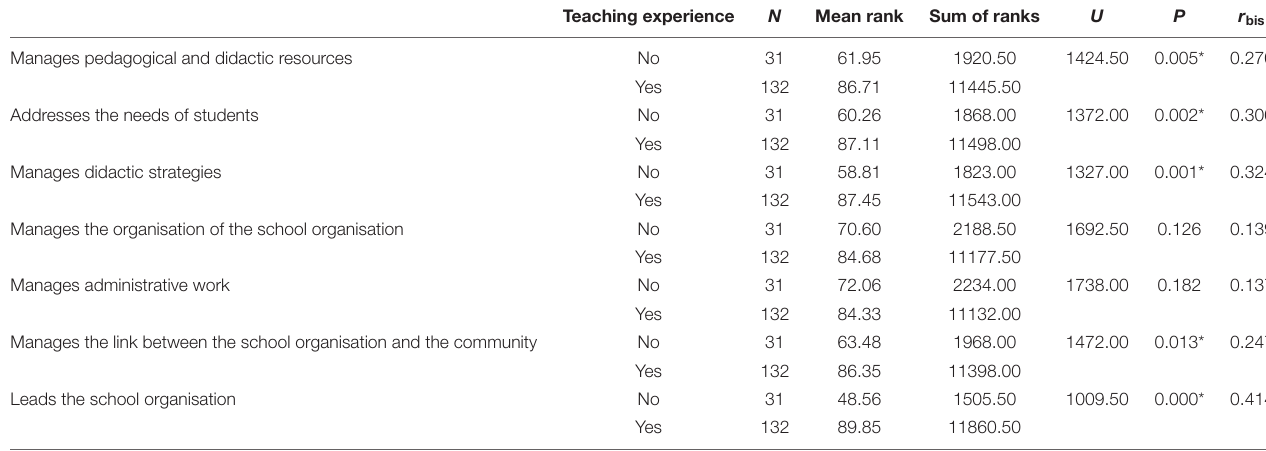
TABLE 4 | Results of Mann-Whitney U test teaching experience vs. no teaching experience in